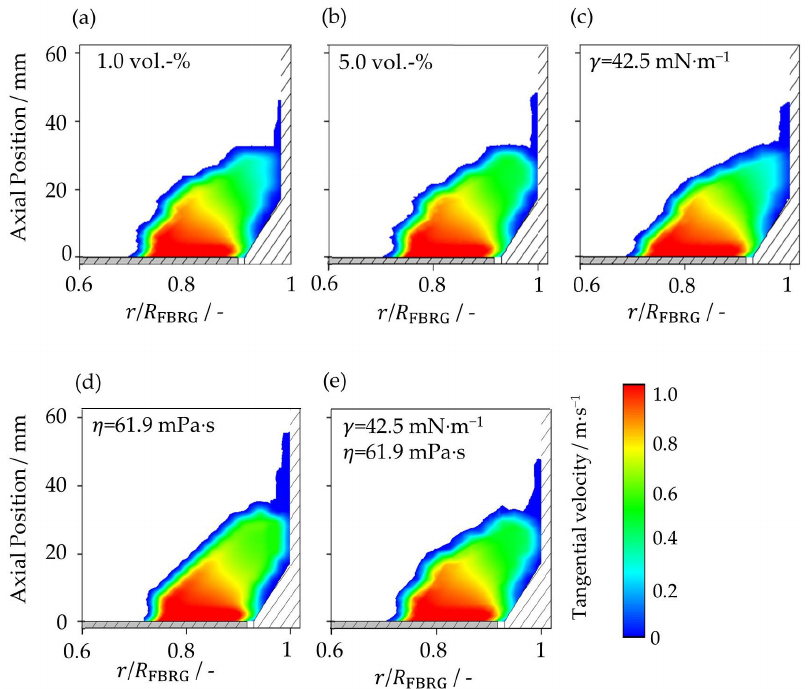
Figure 5. Poloidal distribution of tangential particle velocity at ( a ) liquid loading of 1 vol.-%, ( b ) liquid loading of 5 vol.-%, ( c ) surface tension of 42.5 mN∙m −1 , ( d ) viscosity of 61.9 mPa∙s, and ( e ) ( b ) liquid loading of 5 vol.-%, ( c ) surface tension of 42.5 mN · m − 1 , ( d ) viscosity of 61.9 mPa · s, and surface tension of 42.5 mN∙m −1 and viscosity of 61.9 mPa∙s. ( e ) surface tension of 42.5 mN · m − 1 and viscosity of 61.9 mPa · s.